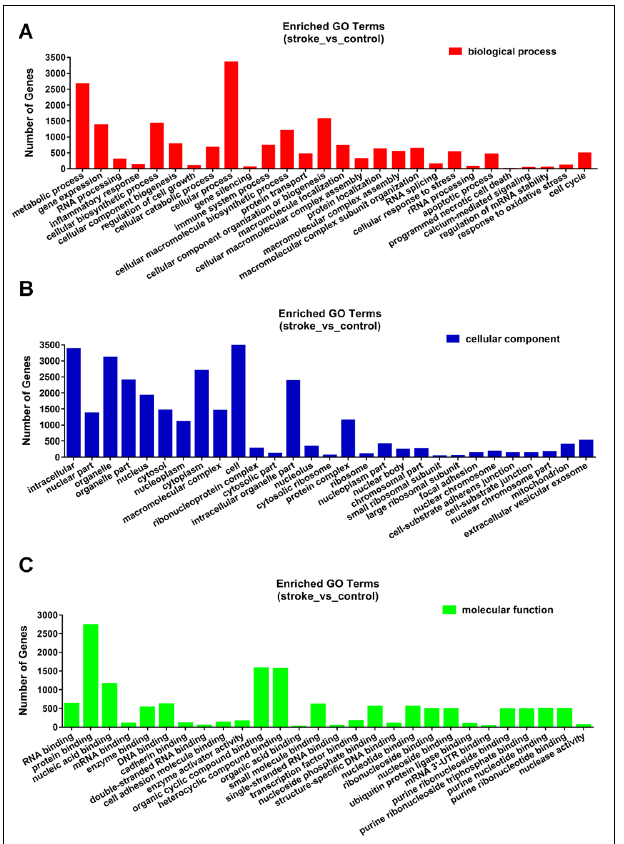
FIGURE 2 | Gene ontology (GO) enrichment analysis of differentially expressed genes in AIS. (A) Biological process. (B) Cellular component. (C) Molecular function.